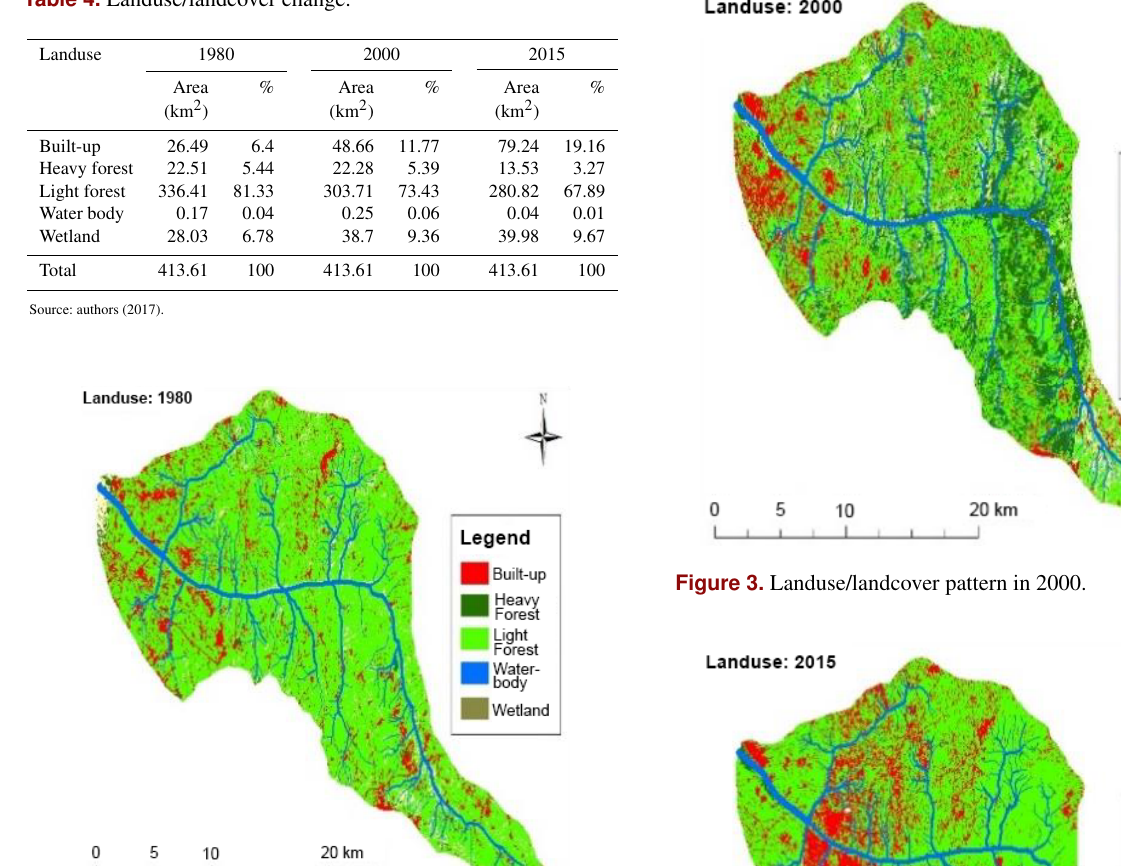
Table 4. Landuse/landcover change.